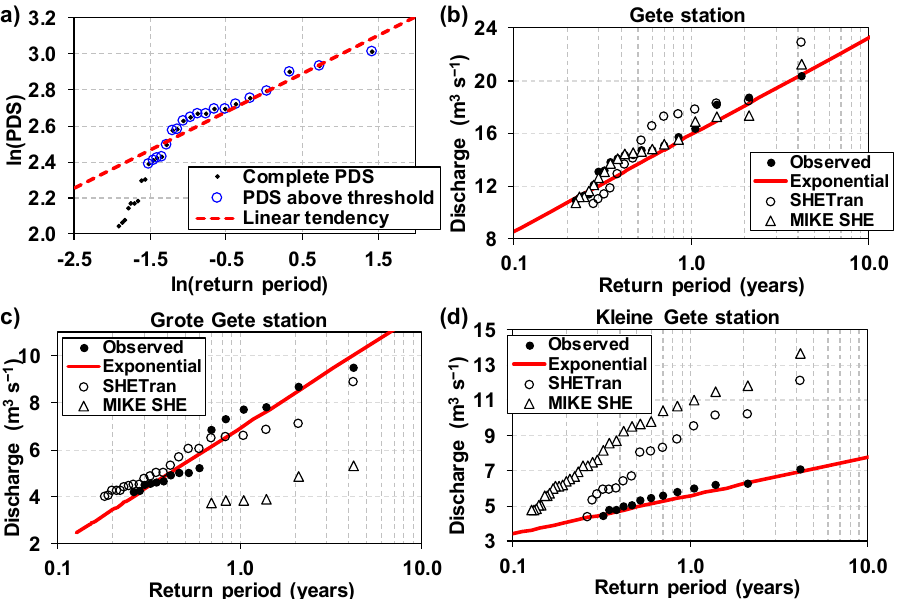
Figure 9. ( a ) Illustration of the process followed to determine the threshold value (x th ) in the peaks over threshold (POT) method using a partial duration time series (PDS) of daily peak values; and (observed and simulated) peak flow empirical distributions for stations ( b ) Gete, ( c ) Grote Gete, and ( d ) Kleine Gete.